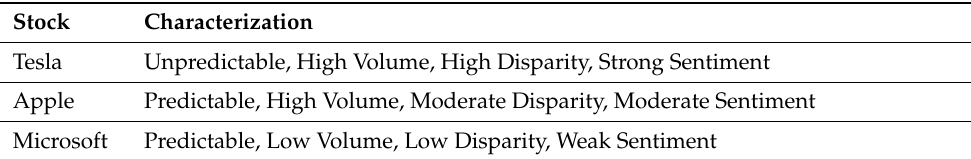
Table 3. Characterization of